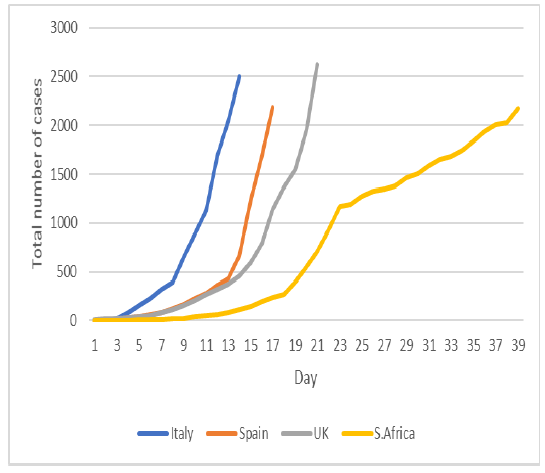
Fig. 12: Total covid cases, UK, Spain, Italy, South Africa